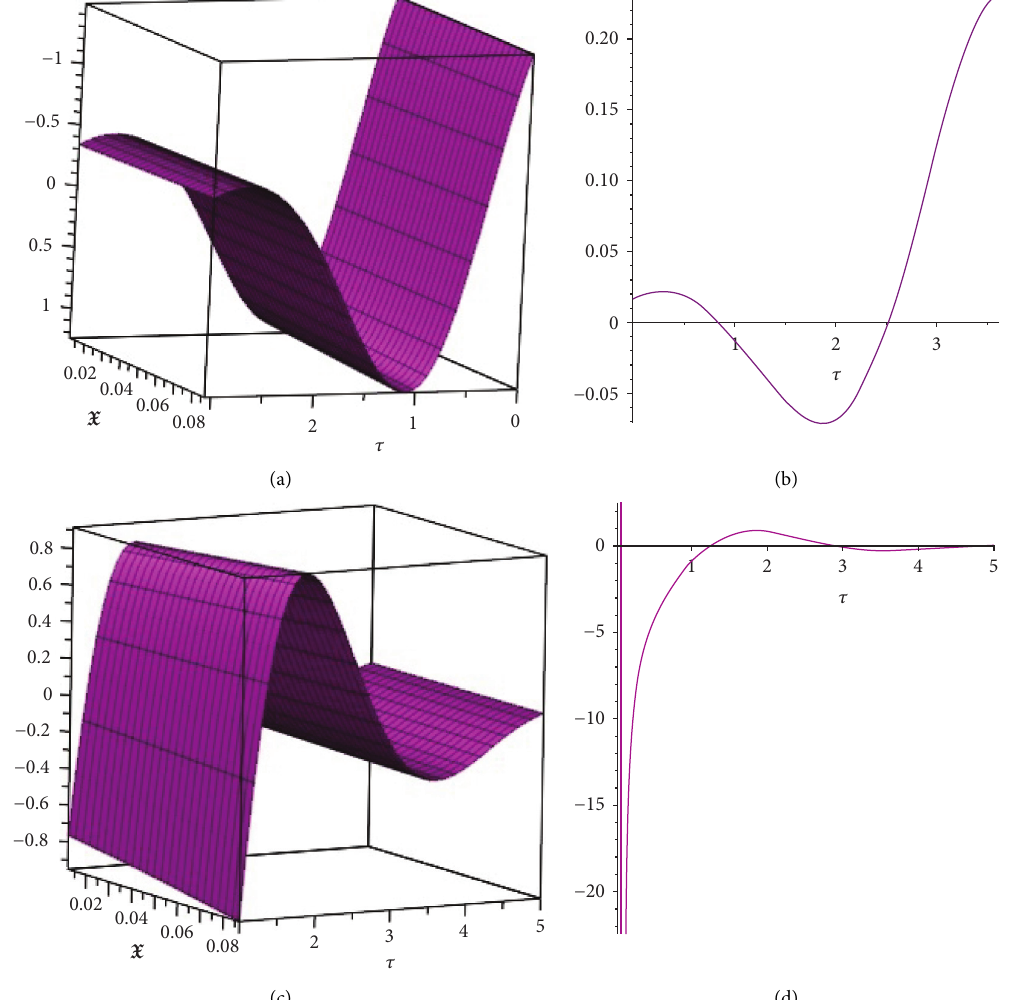
Figure 1: (a, b) 3D and 2D with the real part of solution Ψ the values presented in Section 4.